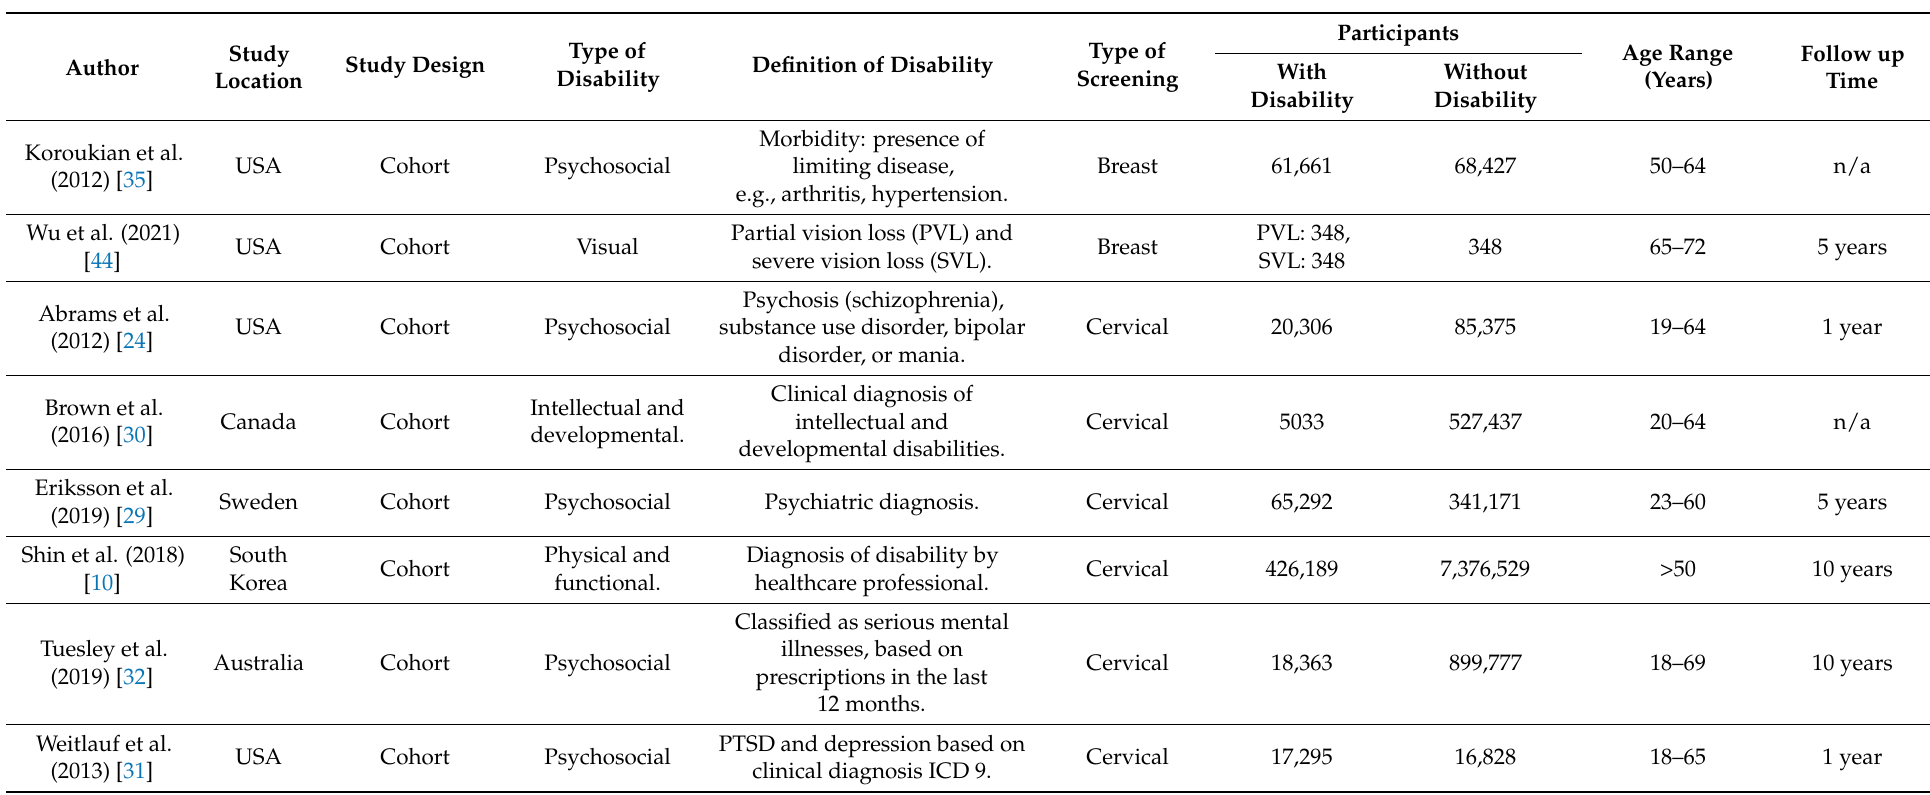
Breast: breast cancer screening. Cervix: cervical cancer